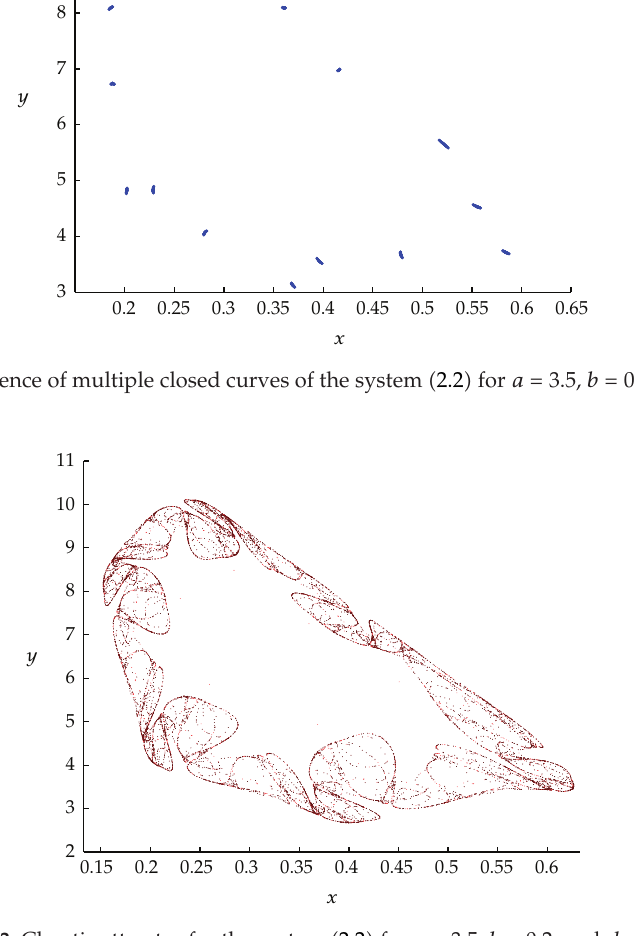
Figure 23: Chaotic attractor for the system (cid:3) 2.2 (cid:4) for a (cid:8) 3 . 5, b (cid:8) 0 . 2, and d (cid:8) 3 .